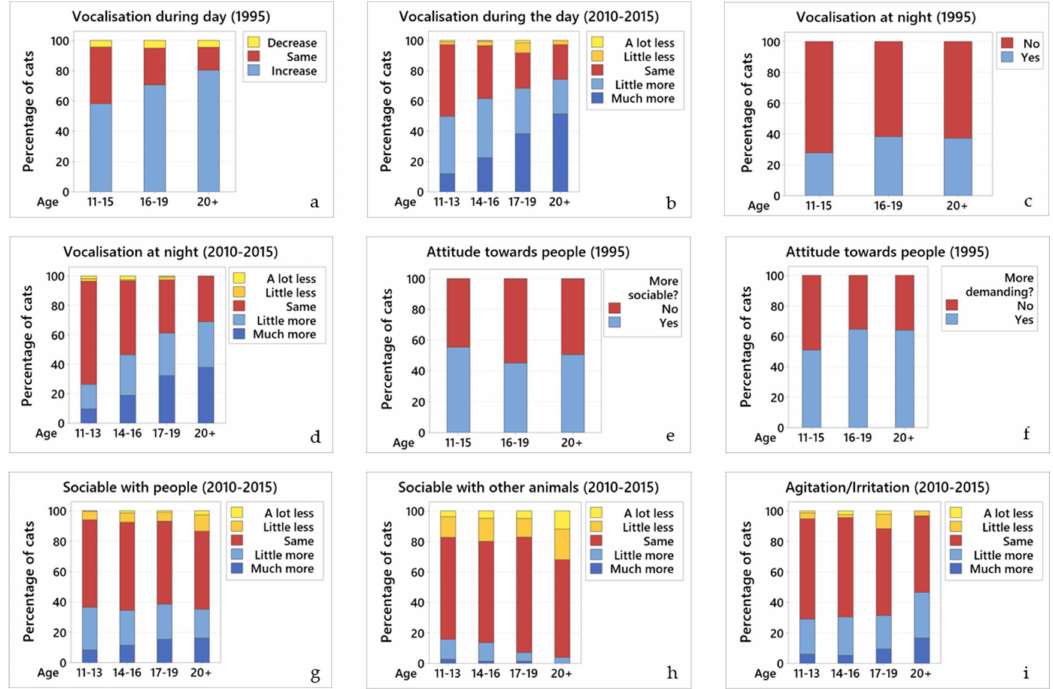
Figure 1. Changes in the di ff erent behaviours across age groups. Comparative graphs showing changes in behaviour across age groups for ( a ) vocalisation during the day (1995); ( b ) vocalisation during the day (2010–2015); ( c ) vocalisation at night (1995); ( d ) vocalisation at night (2010–2015); ( e ) attitude towards people—more sociable (1995); ( f ) attitude towards people—more demanding (1995); ( g ) sociability with people (2010–2015); ( h ) sociability with other animals (2010–2015); and ( i ) agitation / irritation (2010–2015). In all graphs of this panel, blue colours represent an increase in the particular behaviour, yellow represent a decrease, and red represent no